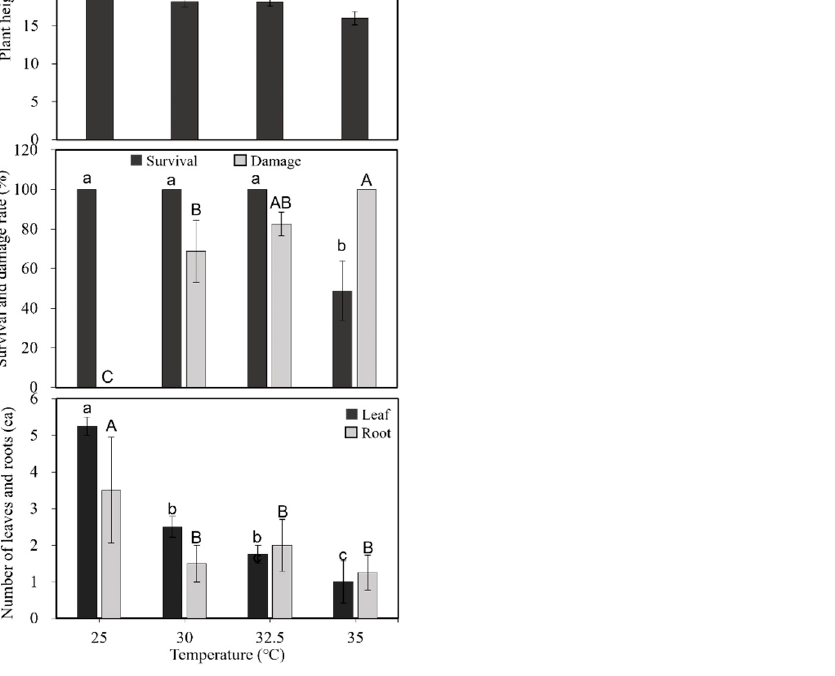
Figure 1. Effect of temperature treatments on plant height, survival, damage rate, number of leaves, and roots of Cnidium officinale —Clone 1. Different letters indicate mean values which are significantly different at p < 0.05 according to Duncan’s multiple range test ( n = 10).